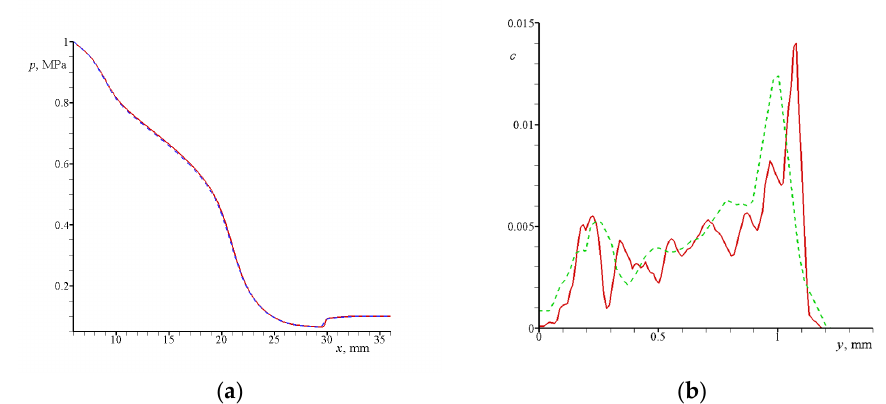
Figure 12. Comparison of data calculated for two values of the number of the gas and particle cells: ( a ) distribution of pressure on the jet axis; ( b ) distribution of particle concentration in the section x = 23 mm. Data shown with solid lines were obtained in the calculation with N (cid:48) c = 207,132 and N (cid:48) c = 16,584, and data shown with dashed lines, in the calculation with N c = 51,783 and N s = 16584.